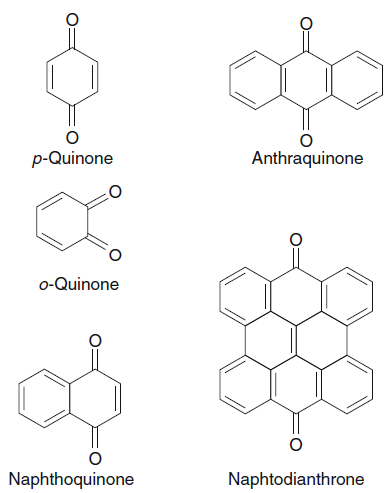
Figure 9. Quinone structures.